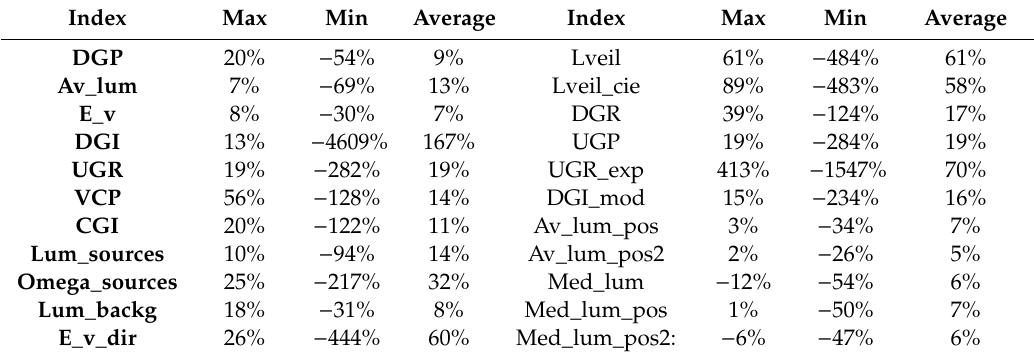
Table 3. Glare score results: the percentage di ff erence in values between the calibrated and non-calibrated images over 22 metrics.